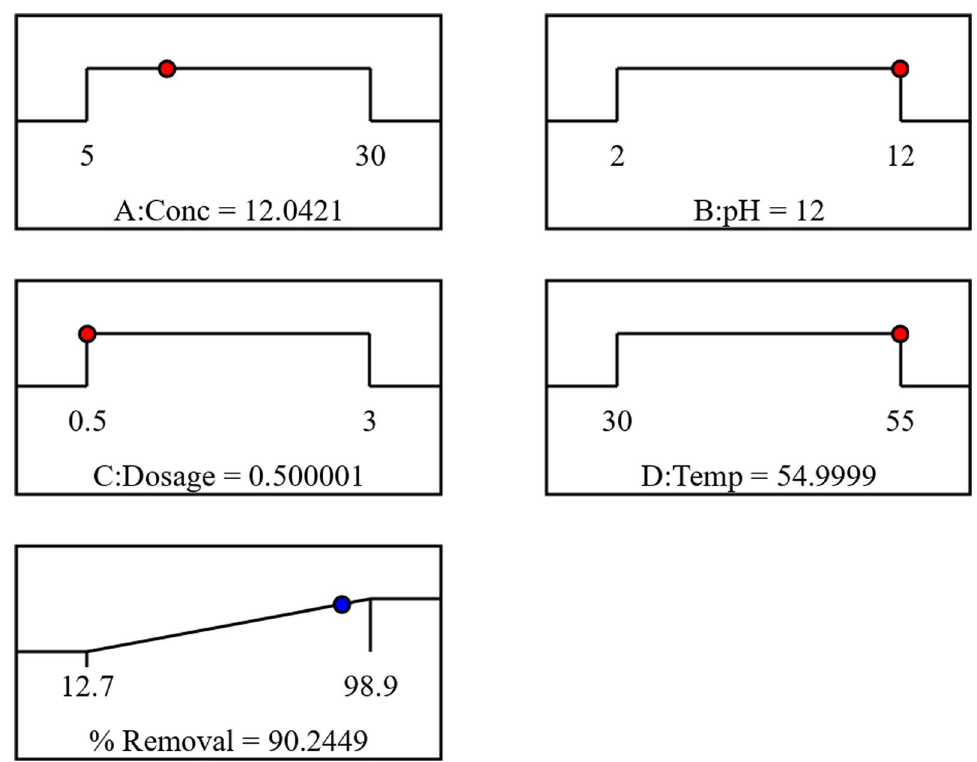
Fig. 9 Actual profiles with predicting points of optimal conditions for Atrazine